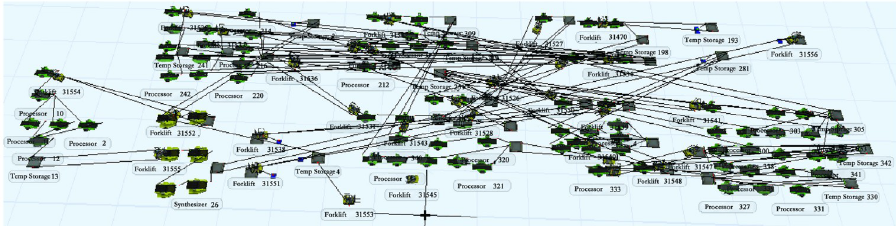
Fig 13. Simulation model of layout logistics system after bearing plant improvement.